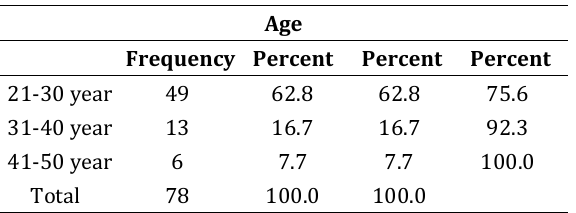
Table 1. Distribution of Respondents by Age in Class II A in Kediri City